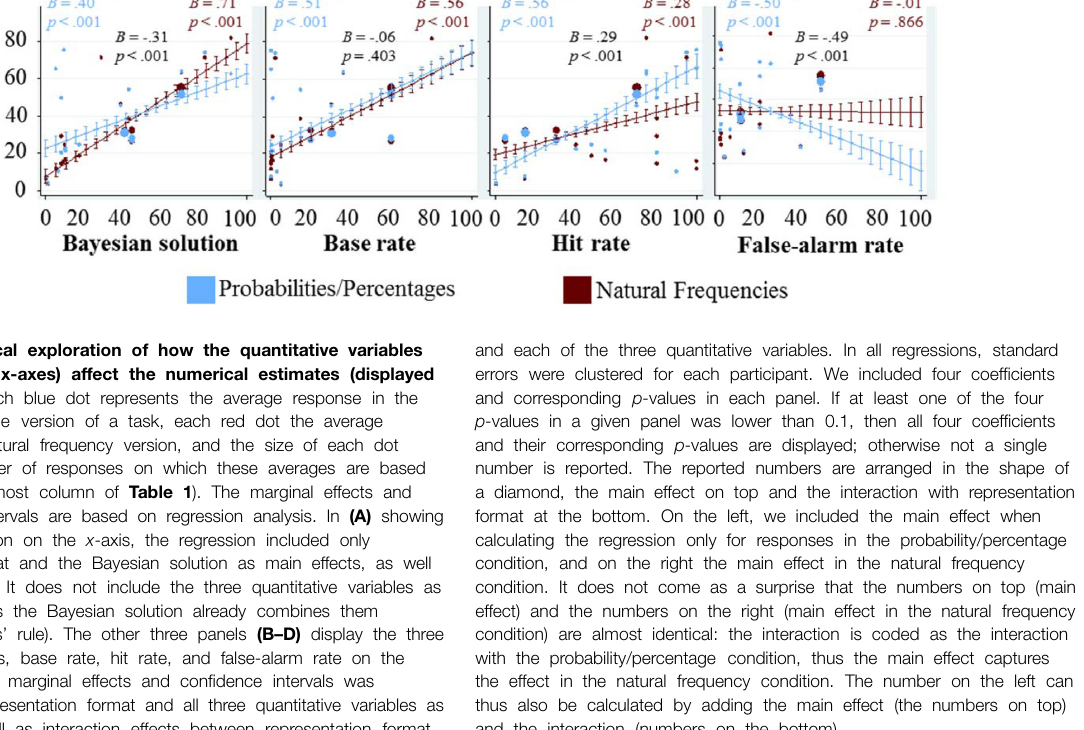
and each of the three quantitative variables. In all regressions, standard errors were clustered for each participant. We included four coefficients and corresponding p -values in each panel. If at least one of the four p -values in a given panel was lower than 0.1, then all four coefficients and their corresponding p -values are displayed; otherwise not a single number is reported. The reported numbers are arranged in the shape of a diamond, the main effect on top and the interaction with representation format at the bottom. On the left, we included the main effect when calculating the regression only for responses in the probability/percentage condition, and on the right the main effect in the natural frequency condition. It does not come as a surprise that the numbers on top (main effect) and the numbers on the right (main effect in the natural frequency condition) are almost identical: the interaction is coded as the interaction with the probability/percentage condition, thus the main effect captures the effect in the natural frequency condition. The number on the left can thus also be calculated by adding the main effect (the numbers on top) and the interaction (numbers on the